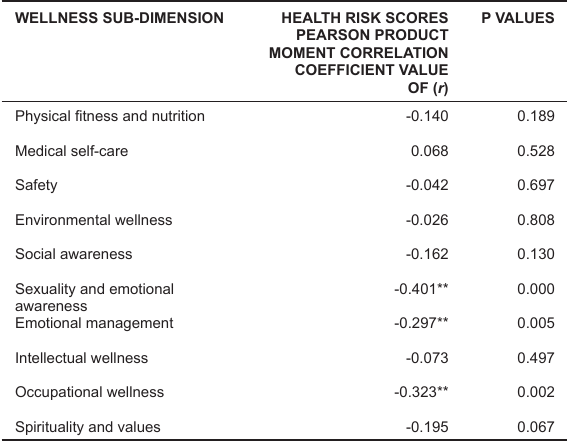
Correlation between the wellness behaviour levels and health risk scores of